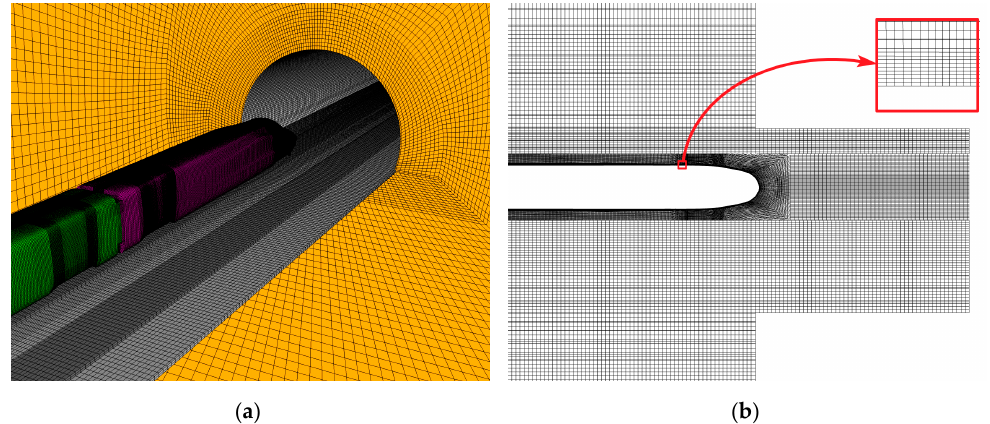
Figure 6. The computational mesh used in simulations: ( a ) Surface mesh distribution of the train, bridge and tunnel, ( b ) mesh distribution around the train.